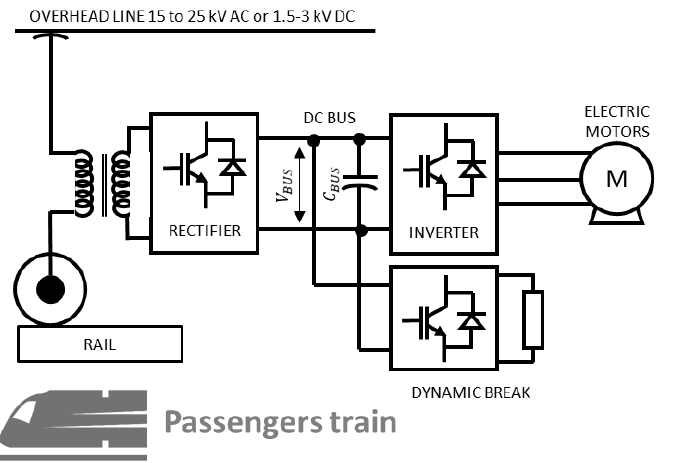
Figure 6. Simplified electrical diagram of the traction drive of a heavy-rail catenary supplied vehi- cles.